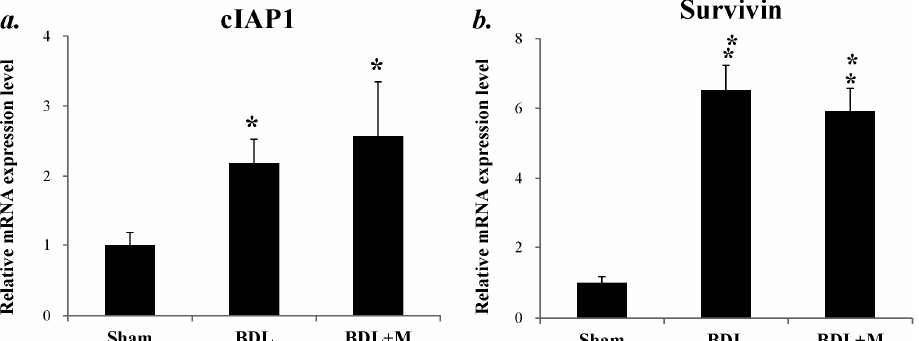
Figure 8. mRNA expression of anti-apoptosis factors. Cellular inhibitor of apoptosis (cIAP1) ( a ) and survivin mRNA ( b ) were increased in BDL rats. Significant difference among three groups was analyzed by one-way ANOVA followed by Bonferroni post hoc. All data are shown as mean ± SEM. * p < 0.05 vs. Sham; ** p < 0.01 vs. Sham.